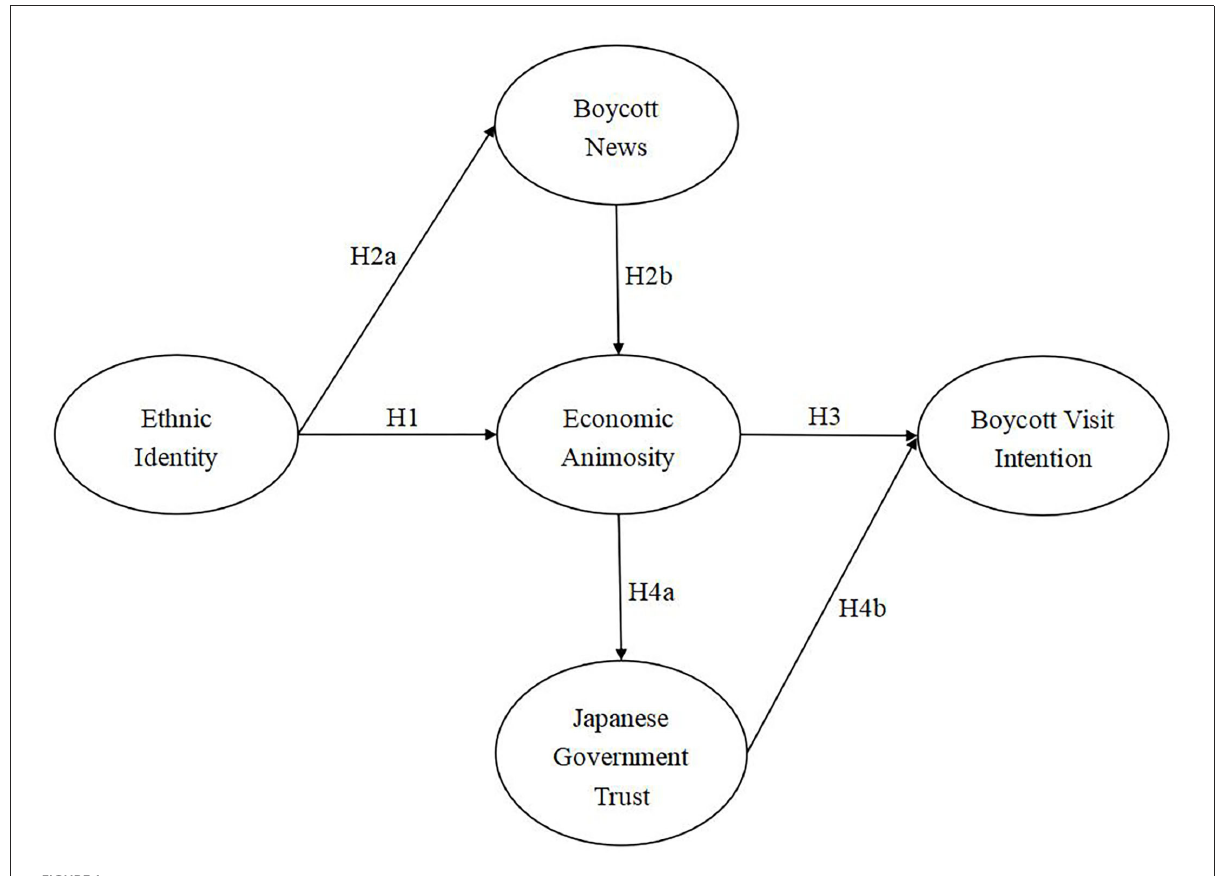
FIGURE1 Research